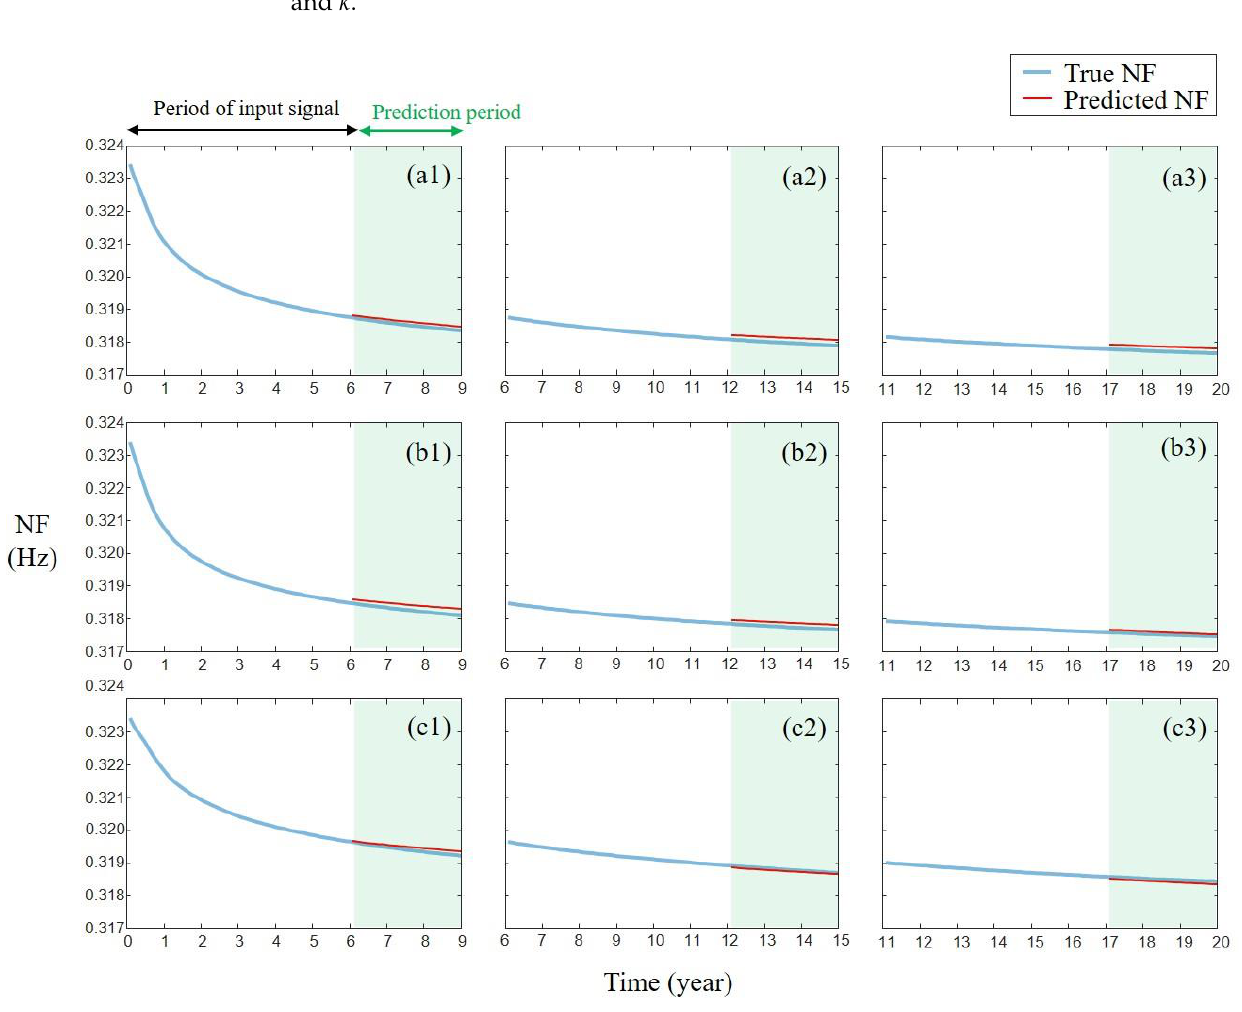
Figure 7. NF prediction examples for different test datasets. Each result shows a degradation ten- dency for a three-year period using the previous six-year data as the input. ( a1 – a3 ), ( b1 – b3 ) and ( c1 – c3 ) represent results corresponding to Cases A, B, and C, respectively.